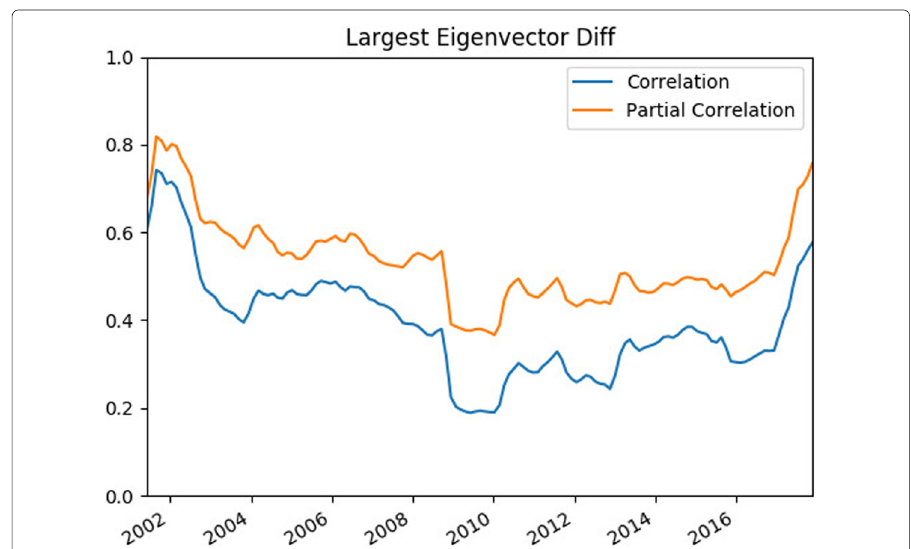
Fig. 6 Change in the normalized leading eigenvectors, measured using the L 2 norm, of the correlation and partial correlation matrices. Both have changes that seem to reflect the general market conditions, although the eigenvector from the partial correlation matrix seems to change more, which shows the network is less